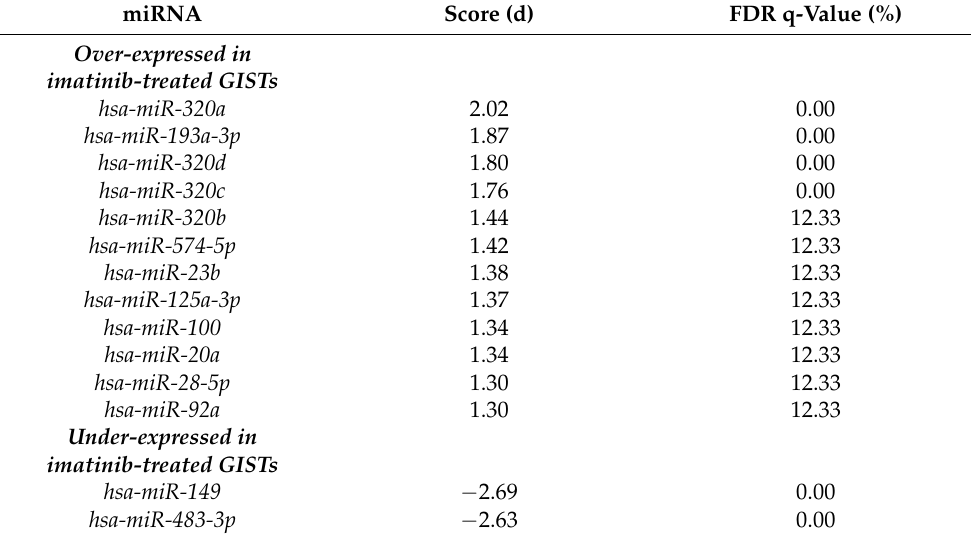
Table 1. Microarray-based SAM results for top miRNAs in imatinib-treated ( n = 19) vs. untreated ( n = 15)